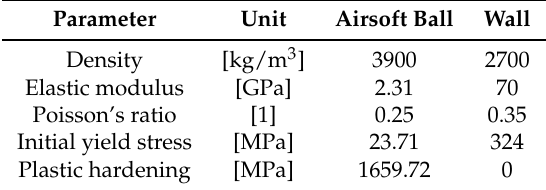
Table 3. The applied elastic-plastic material parameters of the airsoft ball and the aluminum wall. Parameter Unit Airsoft Ball